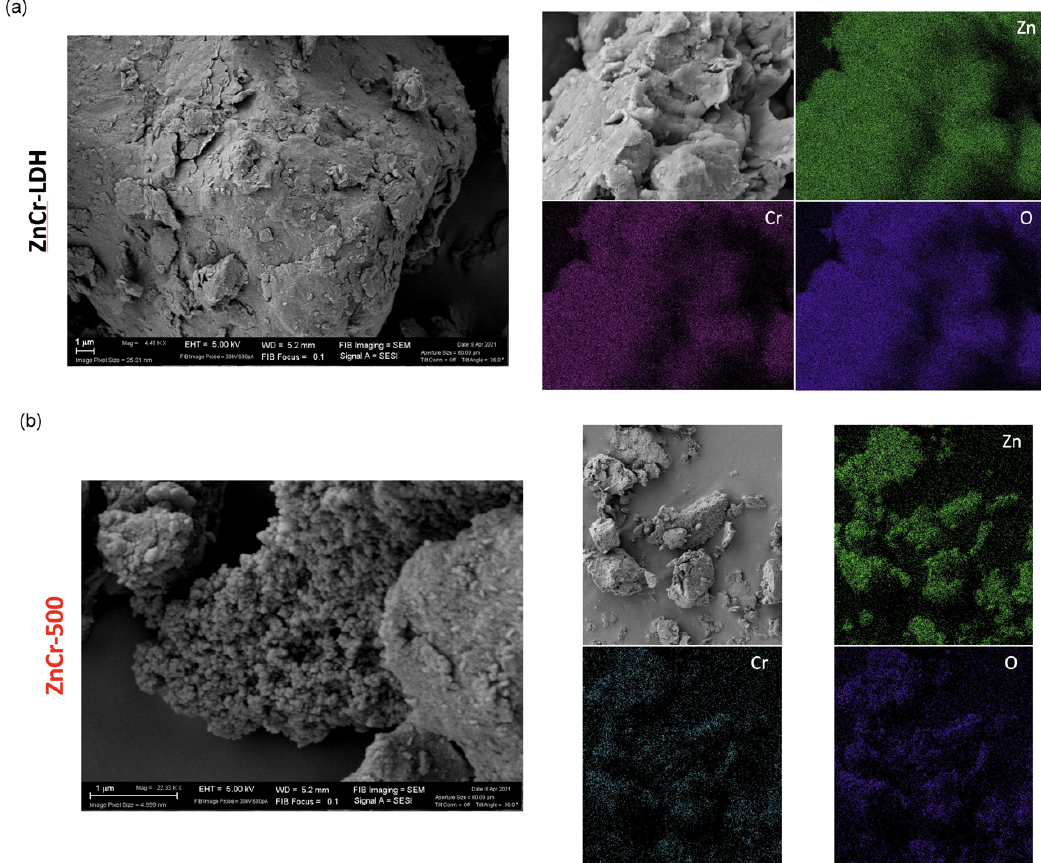
Figure 3. SEM images and EDX mapping of Zn, Cr and O elements for ZnCr-LDH ( a ) and ZnCr-500 ( b ) samples.